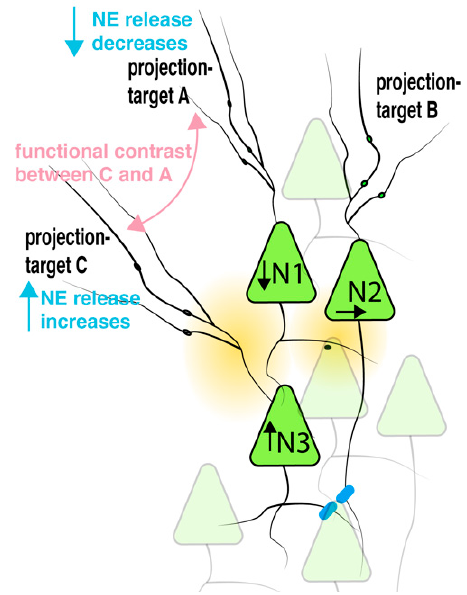
Figure 6. Illustration of functional consequences of a volume-mediated inhibition of neighboring neurons with different projection targets. Strong enduring input to neuron 3, N3, led to an increase in neuronal spiking (arrow up) and a subsequent increased release of NE within the core of the LC. Based on distances and receptor portfolio of neuron 1 (N1) from the release sites of N3, the spontaneous spiking activity in N1 was decreased through activation of GIRK (arrow down), while, for example, activity in neuron 2 (N2) was not altered (arrow horizontal). Consequently, axonal terminals from N3 to projection-target area C increased spike-dependent release of NE, while axons in area A from N1 decreased NE release due to decreased spiking in N1. It is conceivable that the volume-mediated local NE inhibition in the core of the LC led to contrasting functional effects in the neuronal circuits in region C and A, i.e., facilitating sensory saliency in region C versus region A. Supplementary Materials: The following supporting information can be downloaded at: https:// for the spontaneous spiking of the cell; Figure S2: Inward-rectification presented in a current- voltage plot derived from HEK293 that heterologus express GIRK2 channels. GIRK time course are used in Equation (13); Figure S3: Confocal images of immunostained brainstem slices against tyrosine hydroxylase (TH/green) and dopamin-beta-hydroxylase (DbH/magenta) at three different position from bregma: − 5.40, − 5.52 and − 5.68 mm; Figure S4: Spike rate dependence on 300-ms current-injection steps separated for early spikes (spike 1 and 2/dotted line) versus later spikes (>spike 2/full line); Figure S5: Action potential triggers calcium accumulation in the cell which facilitates the release of neurotransmitters along with many other calcium-triggered events; Figure S6: Effect of extracellular NE that diffuses freely in the extracellular